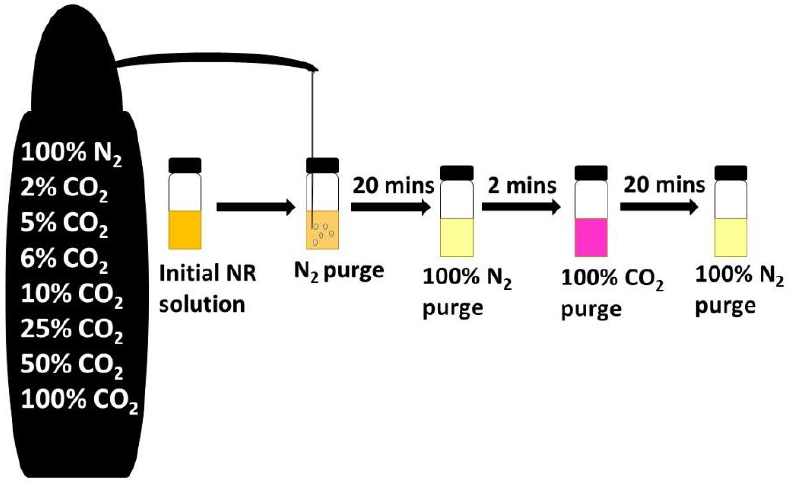
Figure 2. Schematics showing the sequential steps for purging studies of Neutral Red (NR) using different gas mixtures of CO 2 /N 2 in a fluorometer.